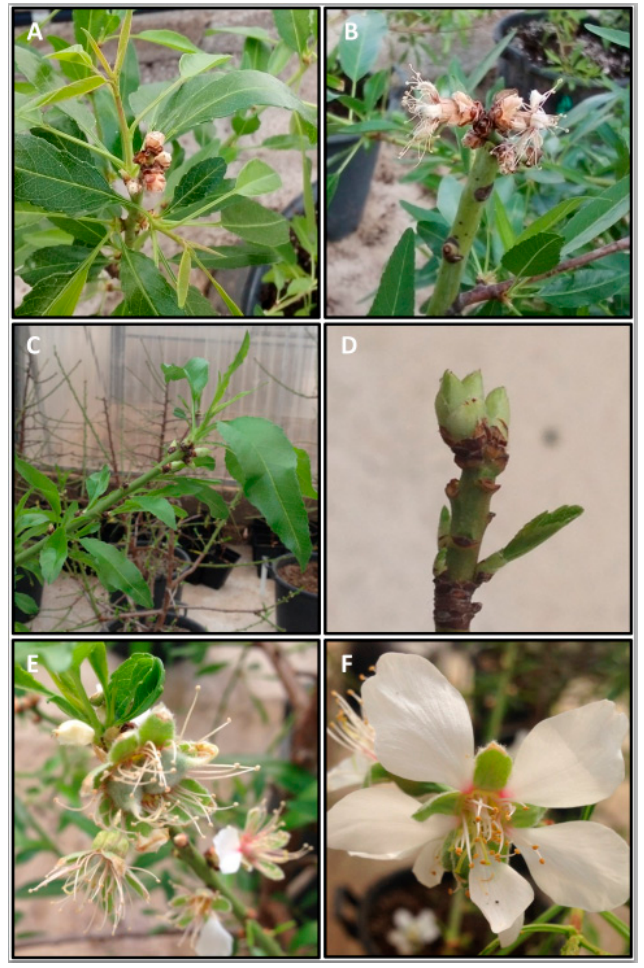
Figure 6. Tardona flower bud failure. Dried flower buds in different phenological states ( A , B ) and anomalous flower buds surrounded by leaves ( C , D ). Double ( E ) and multipistil ( F ) formation observed in Tardona flowers.